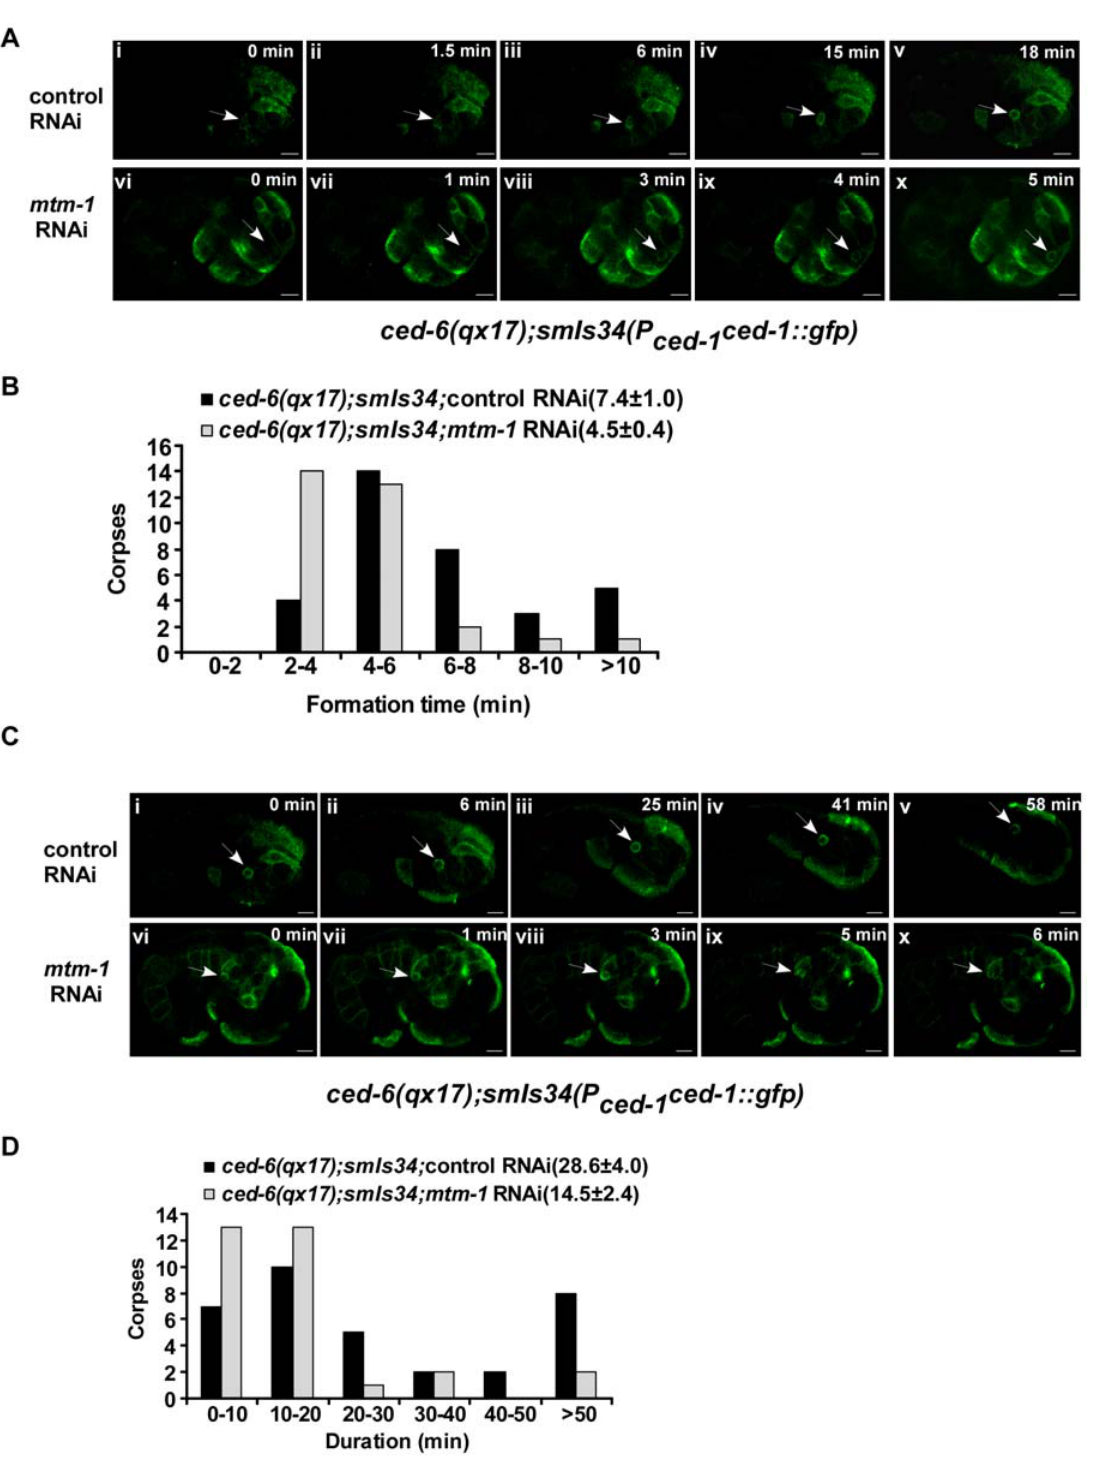
Figure 4. mtm-1 RNAi accelerates the engulfment of cell corpses. (A) The formation of CED-1::GFP rings around cell corpses was followed and confocal time-lapse images of ced-6(qx17);smIs34( P ced-1 ced-1::gfp ) embryos treated with either control (i–v) or mtm-1 RNAi (vi–x) are shown. The time point immediately prior to the appearance of trace amounts of CED-1::GFP adjacent to each cell corpse (arrowed) was set as 0 min. Bars: 5 m m. (B) Quantification of data shown in (A). 34 and 31 cell corpses were followed in control and mtm-1 RNAi-treated embryos, respectively. Numbers in parenthesis indicate the average formation time of the CED-1::GFP ring ( 6 s.e.m). (C) The duration of CED-1::GFP around each cell corpse was followed and confocal time-lapse images of ced-6(qx17);smIs34 (P ced-1 ced-1::gfp ) embryos treated with either control (i–v) or mtm-1 RNAi (vi–x) are shown. The first time point (0 min) was set when a full CED-1::GFP ring (arrowed) was just seen. Bars: 5 m m. (D) Quantification of data shown in (C). 34 and 31 cell corpses were quantified in control and mtm-1 RNAi-treated embryos, respectively. Numbers in parenthesis indicate the average duration time of the CED-1::GFP ring ( 6 s.e.m).